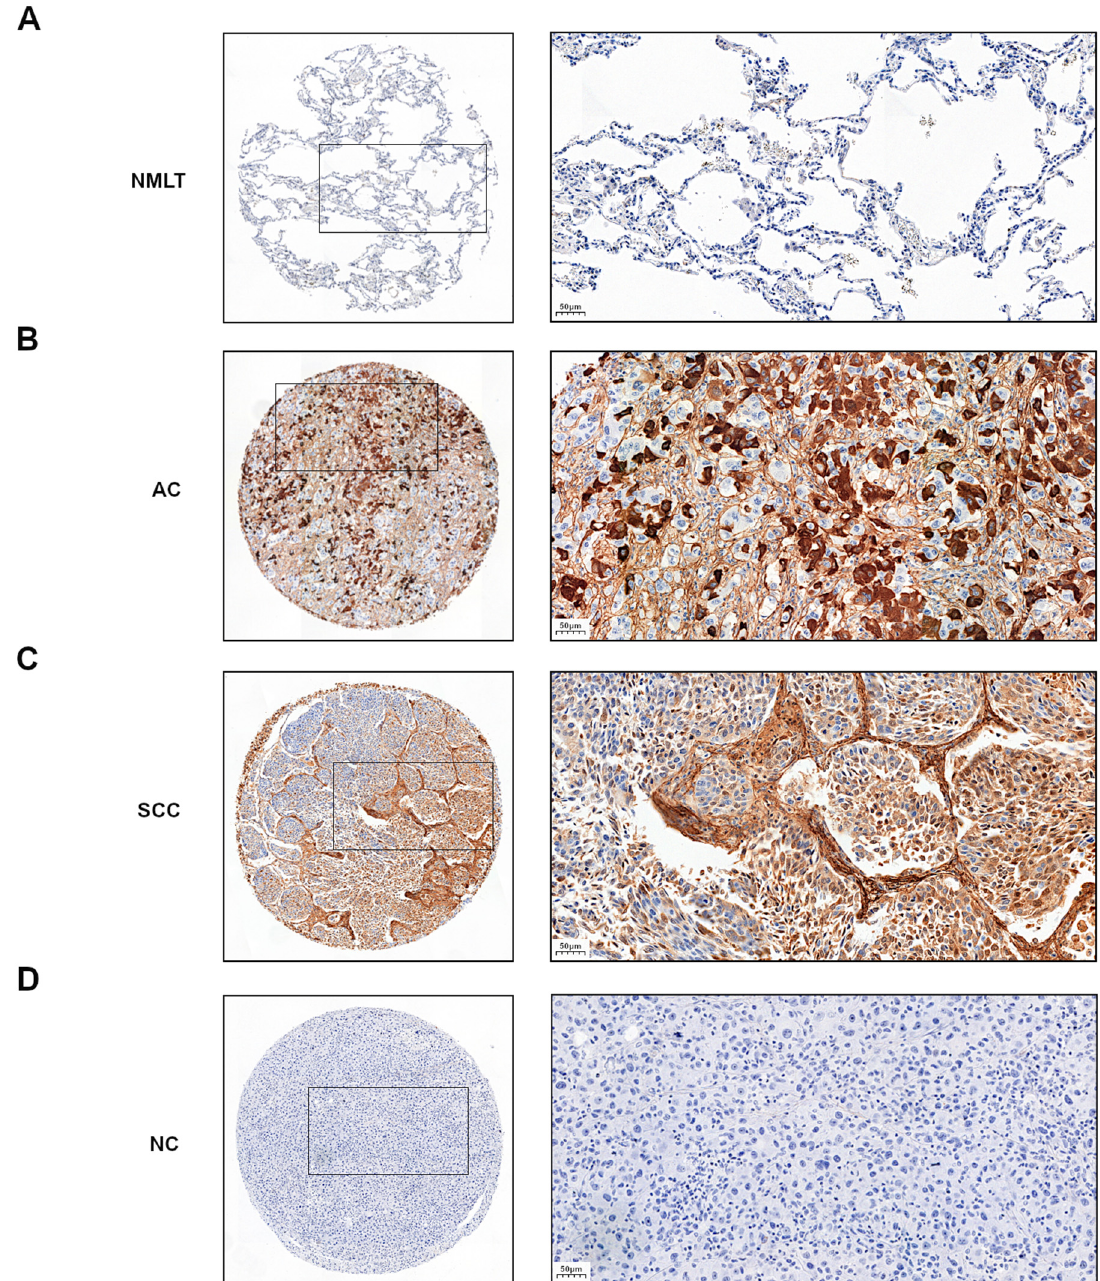
Figure 1. Representative immunohistochemical images with cytoplasmic periostin (POSTN) expression in ( A ) non-malignant lung tissue (NMLT) and non-small cell lung carcinoma (NSCLC) subtypes: ( B ) adenocarcinoma (AC) and ( C ) squamous cell carcinoma (SCC). ( D ) negative control (NC). Magnification 50×, 200×. Bar =200 µm and 50 µm, respectively.